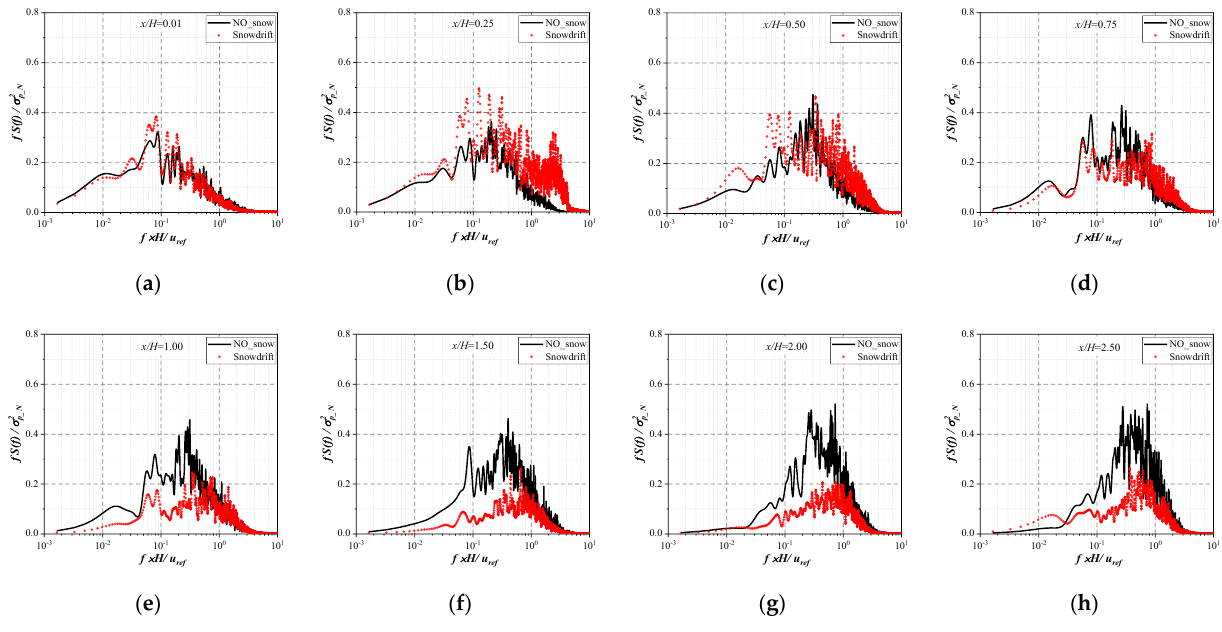
Figure 17. Power spectral density of fluctuating wind pressure at monitoring points (( a ) x/H = 0.01; ( b ) x/H = 0.25; ( c ) x/H = 0.5; ( d ) x/H = 0.75; ( e ) x/H = 1.0; ( f ) x/H = 1.5; ( g ) x/H = 2.0; ( h ) x/H = 2.5).